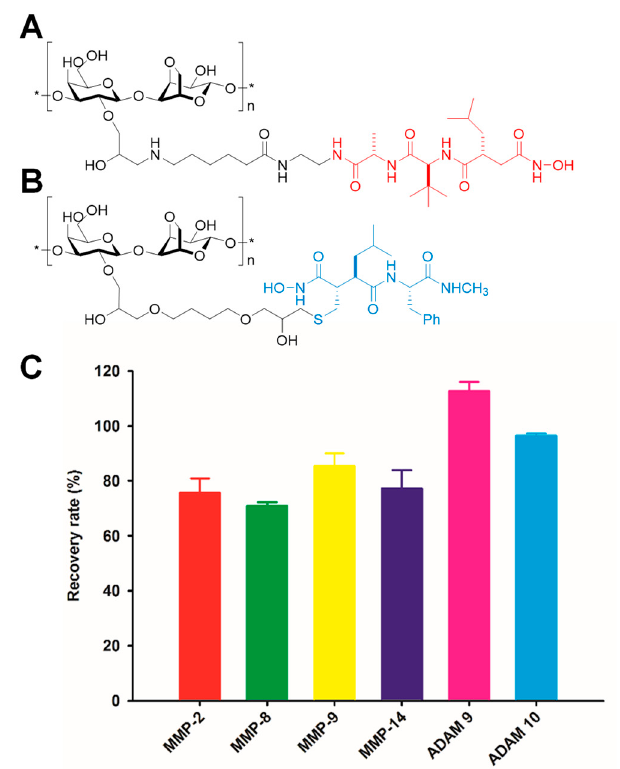
Figure 2. Structures of ( A ) the TAPI-2 affinity resin and ( B ) the batimastat affinity resin used to capture active MMPs and related ADAMs (a disintegrin and metalloproteinase). The portion of the structure based on TAPI-2 is indicated in red and that based on batimastat is shown in blue. ( C ) Recovery of representative active MMPs and ADAMs by the batimastat affinity resin. Mouse tissue homogenate was spiked with 10 pmol of proteinase and incubated with the resin. Recovery was determined from quantitation of the proteinase recovered after the clean-up procedure relative to the spiked amount; mean ± SD, n = 3.